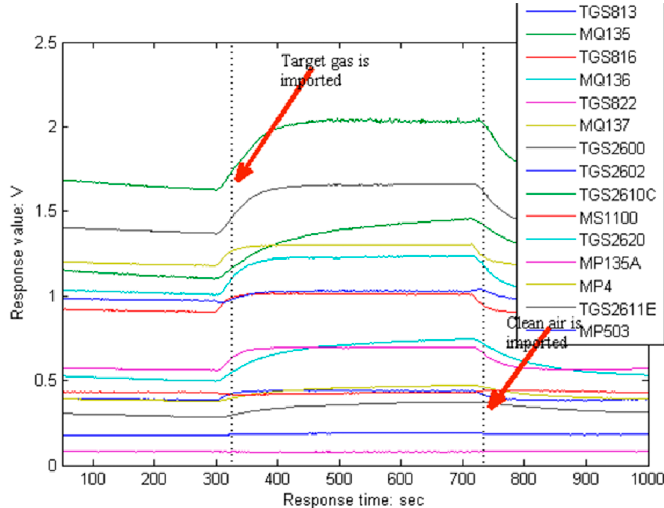
Figure 4. The response of the sensor array. Note: Strictly speaking, the response of the metal oxide sensor (MOS) should be the resistance value, and the response of the vertical coordinate in this diagram is the voltage value, which is the voltage value that we use in the circuit (designed by ourselves) to transform the change of resistance value to the change of voltage value. The resistance of the sensor is different when the gas environment is different, and the voltage value is also different, so we take the voltage value as the response value of sensors in this